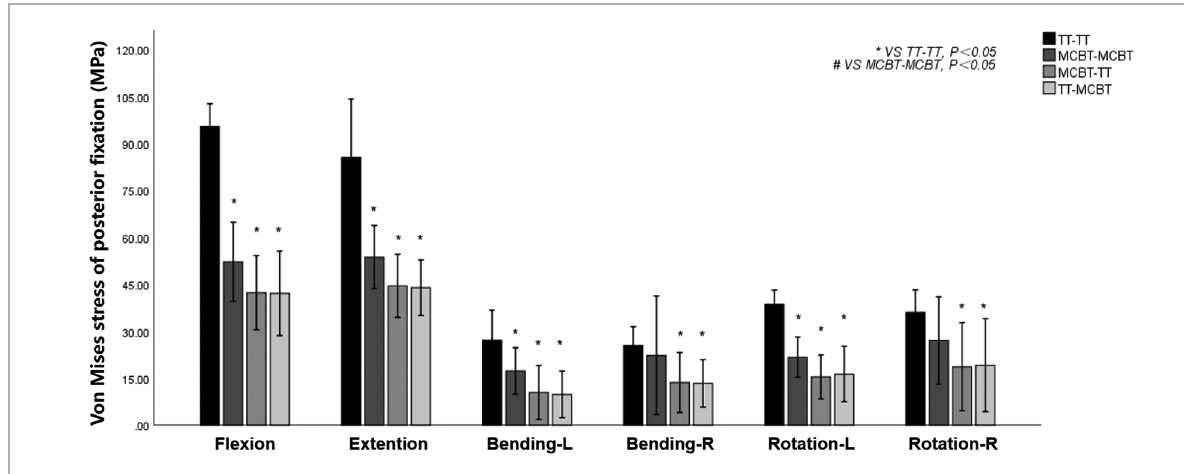
FIGURE 7 Mean values and minimum – maximum ranges of the posterior fi xation stress in four fi xation